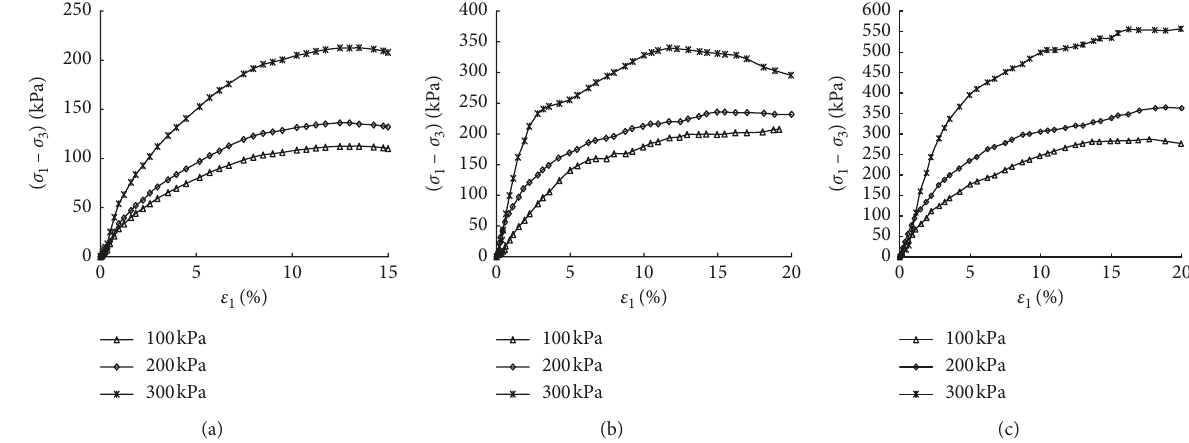
Figure 7: Relationship between the deviator stress and axial strain of flax fiber-reinforced clay (FRC) and bamboo strips and flax fiber- reinforced clay (BFRC) under different confining pressures. (a) Pure clay. (b) Flax fiber-reinforced clay. (c) Bamboo strips and flax fiber- reinforced clay.